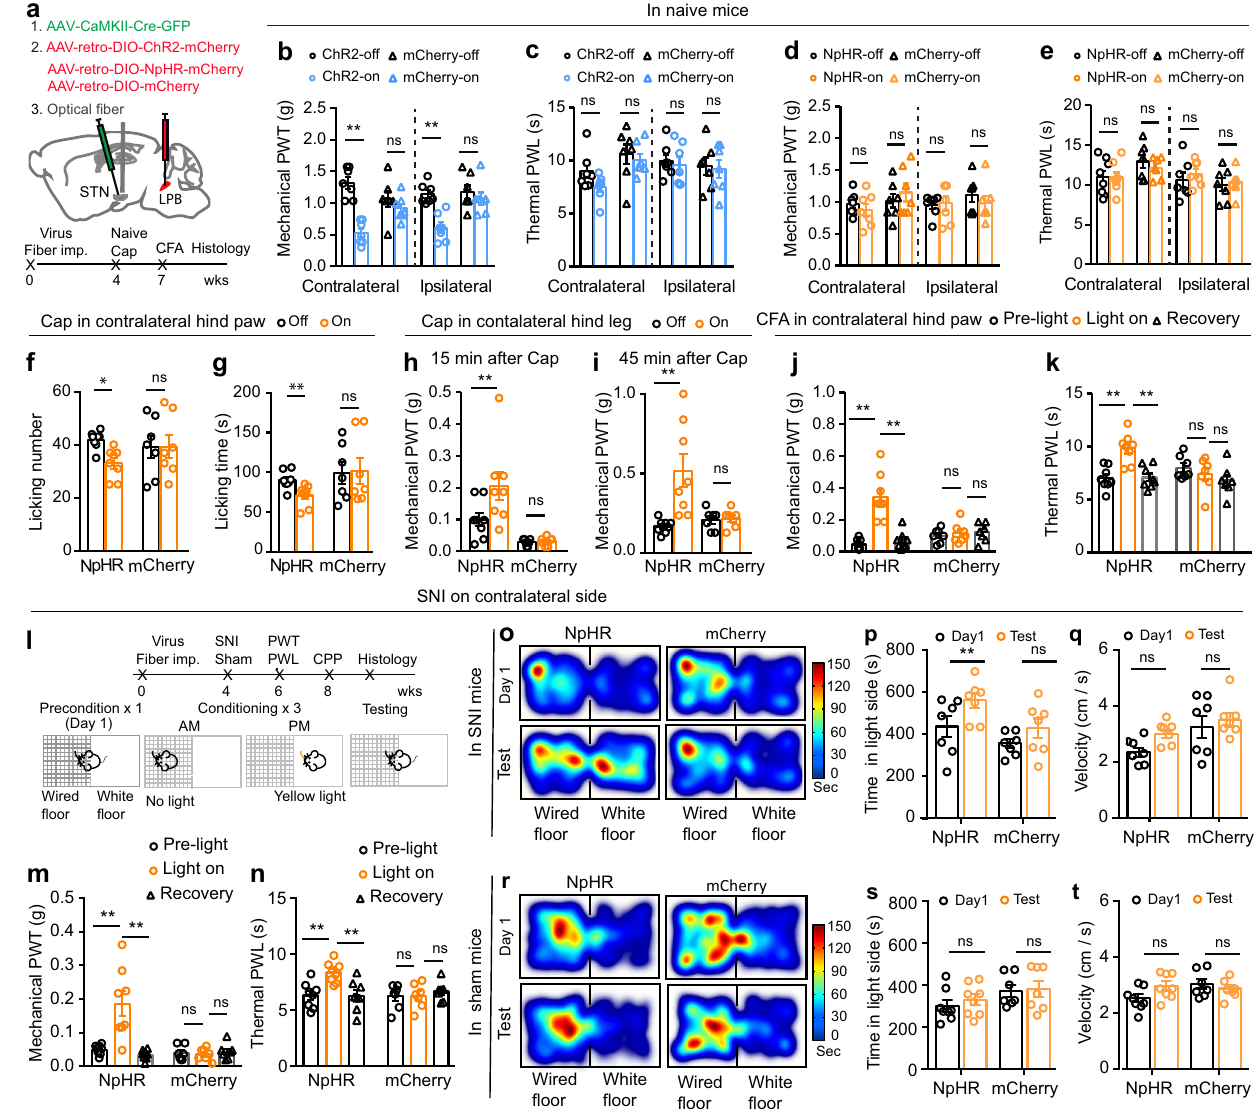
Fig.4|STN – LPBneuronsmodulatepain-likebehaviors.a Experimentaldiagram for optogenetic manipulation of STN – LPB neurons. Timeline for panel ( b – k